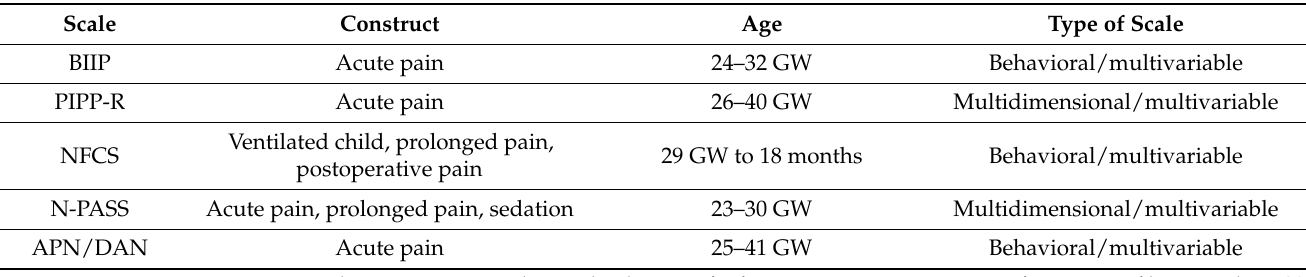
Table 1. Neonatal Pain Scales for different target populations